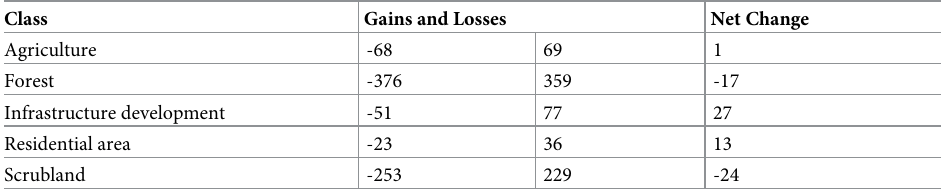
Table 8. Gain and losses, and net change of land cover between 2010 and